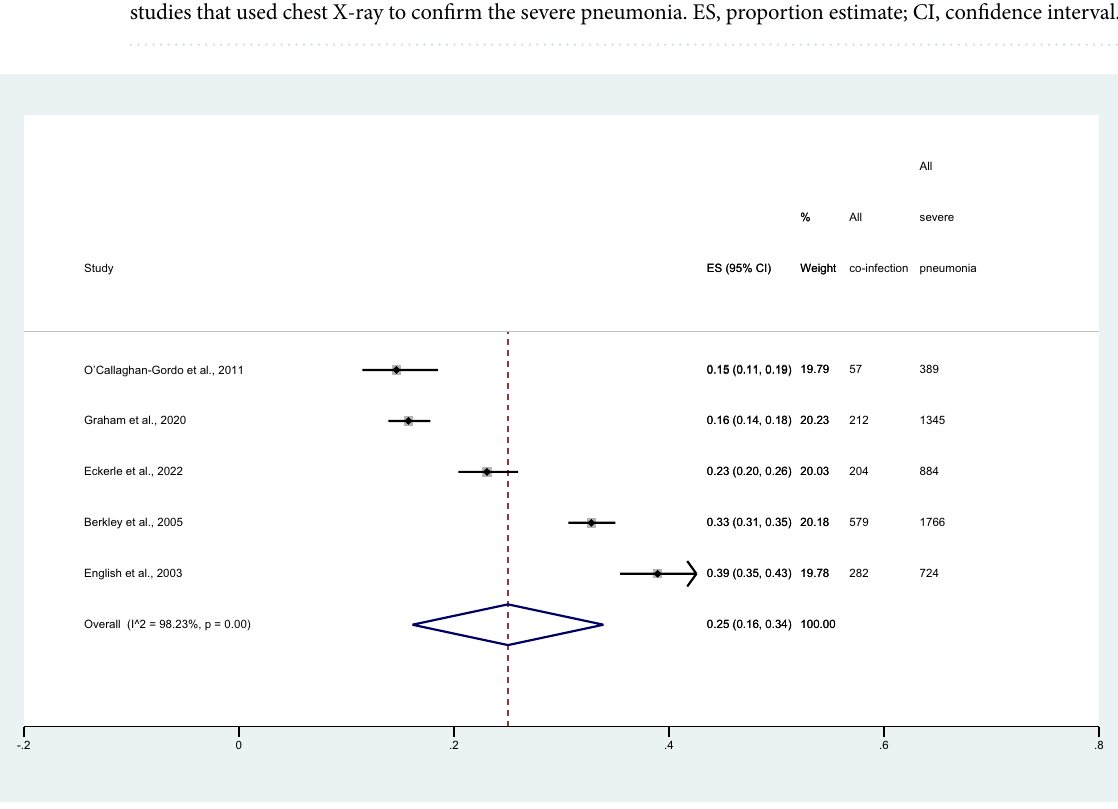
Figure 8. Forest plot demonstrates the pooled proportion of malaria among patients with severe pneumonia in studies that used WHO criteria for pneumonia (IMCI definition) to confirm the severe pneumonia. ES, proportion estimate; CI, confidence